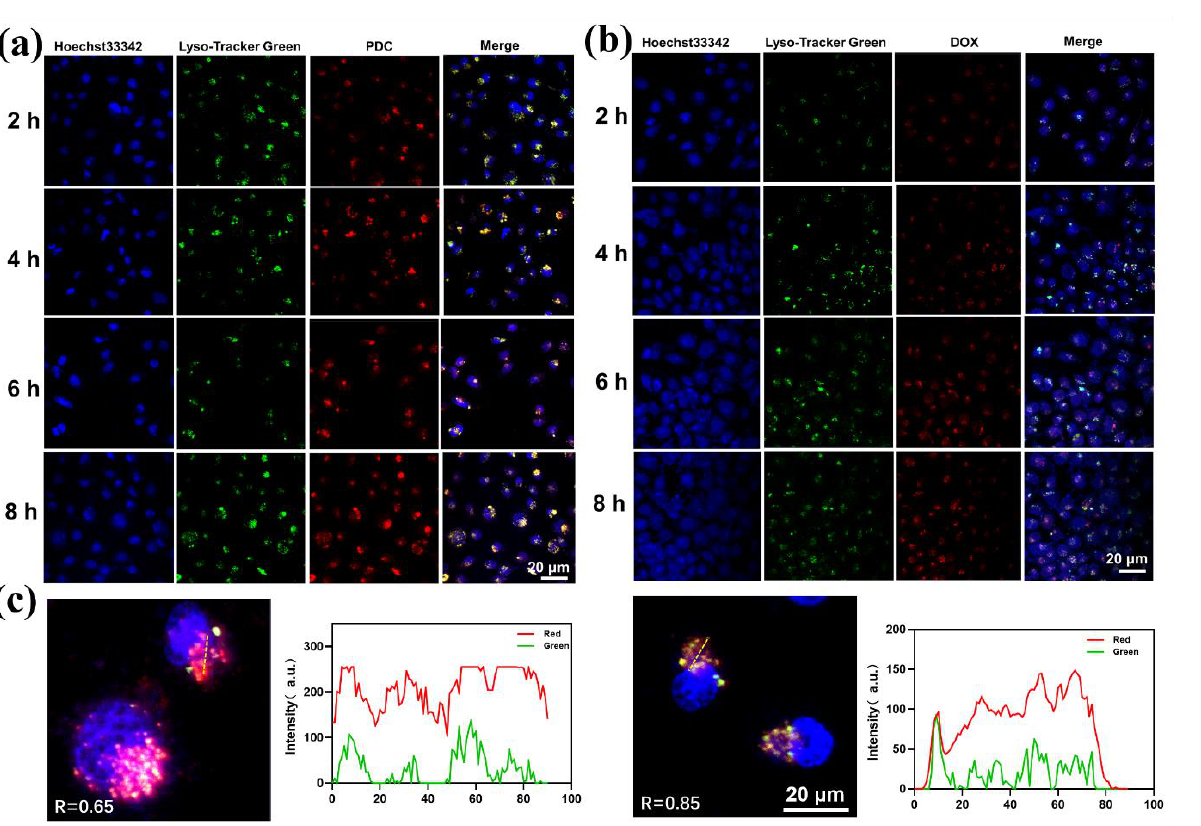
Figure 4. ( a ) CLSM imaging of the SKBR-3 cells’ uptake of the PDC. ( b ) CLSM imaging of the SKBR-3 cells’ uptake of free DOX. Blue, green, and red channels stand for the fluorescence of Hoechst33342, LysoTracker, and DOX, respectively. The scale bar is 20 µ m. ( c ) Representative fluorescence images showing the colocalization of the PDC or DOX with the LysoTracker for 8 h. Red: DOX. Green: LysoTracker. Blue: Hoechst 33342. Fluorescence intensity analyses of pixels along the dotted line were measured by ImageJ.